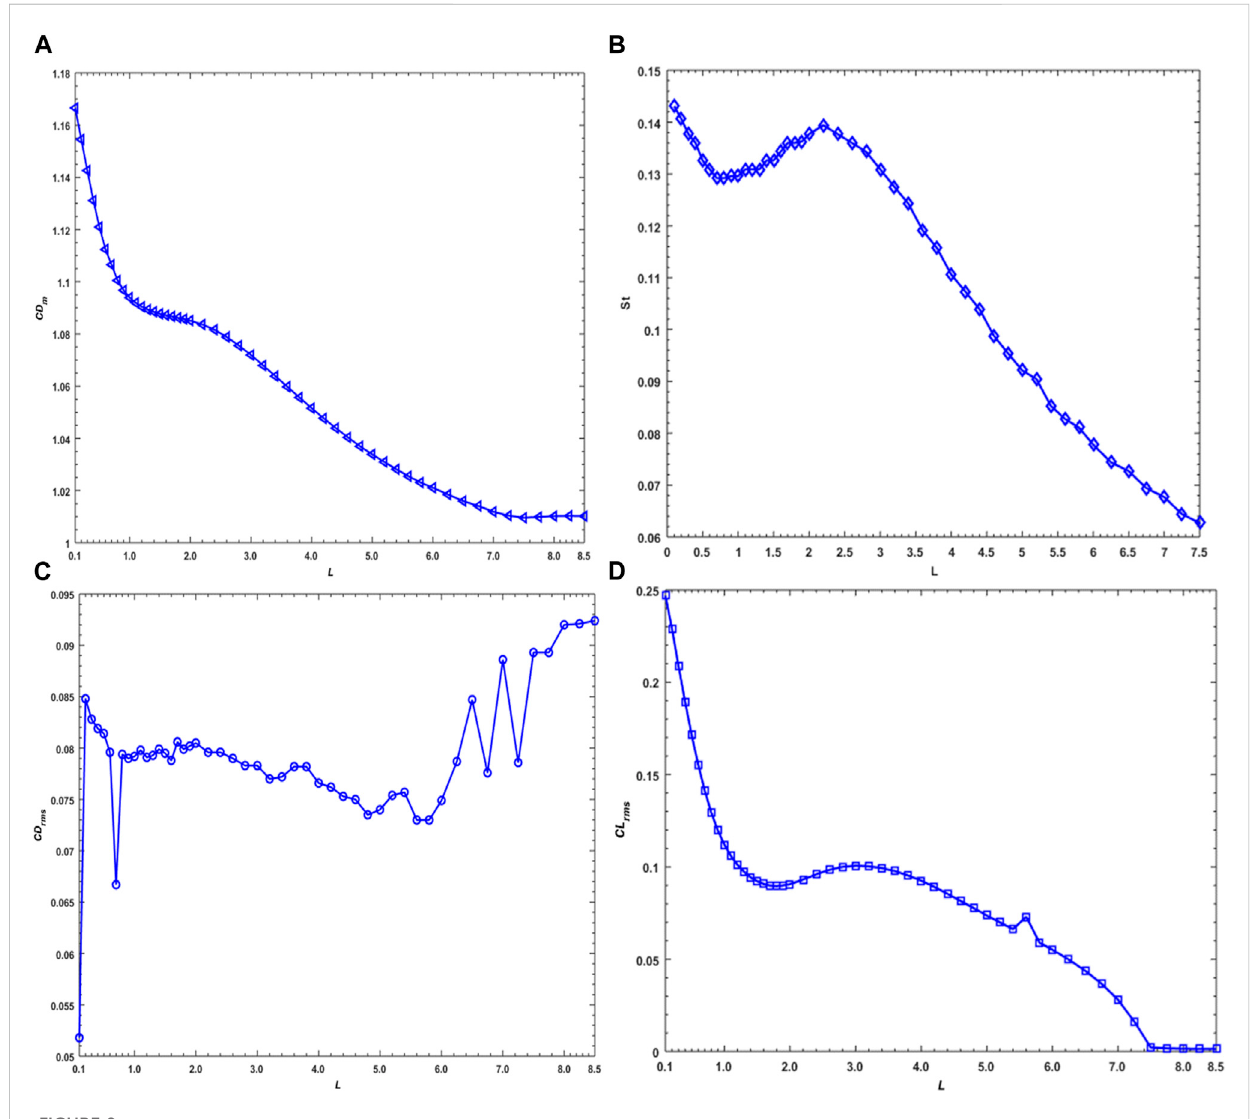
FIGURE 9 Variation of (A) average CD , (B) St , (C) CD rms and (D) CL rms with plate